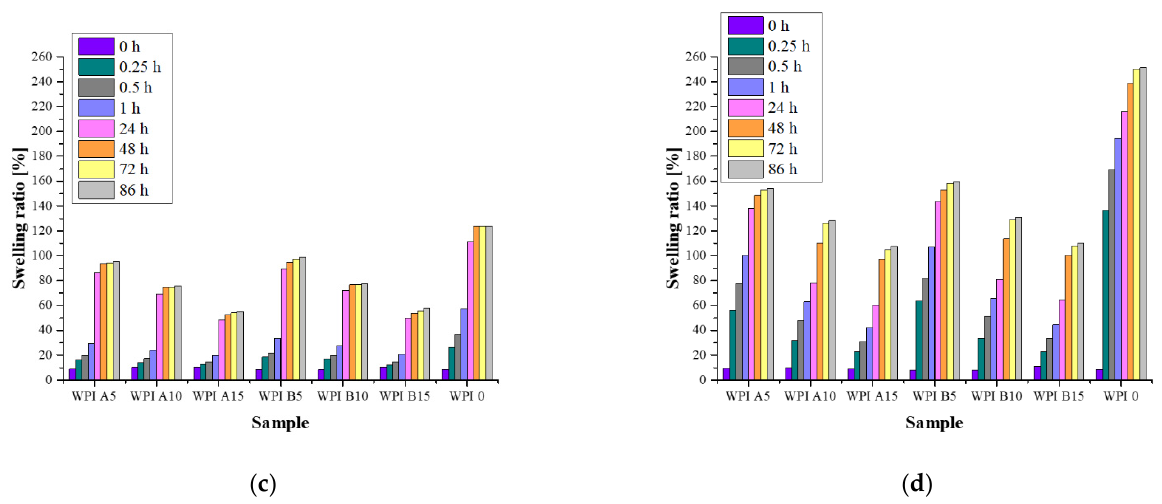
Figure 5. Swelling ability of hydrogels during a 14-day incubation in fluids simulating the biological environment: ( a ) incubation in artificial saliva; ( b ) incubation in SBF; ( c ) incubation in Ringer’s fluid; ( d ) incubation in distilled water.